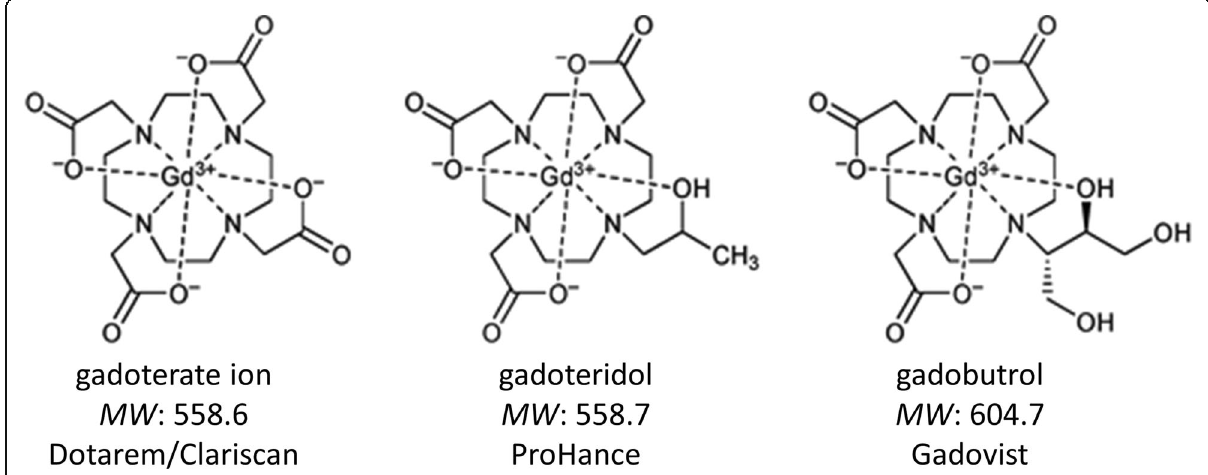
Fig. 3 Chemical structures and molecular weights (MW) of macrocyclic